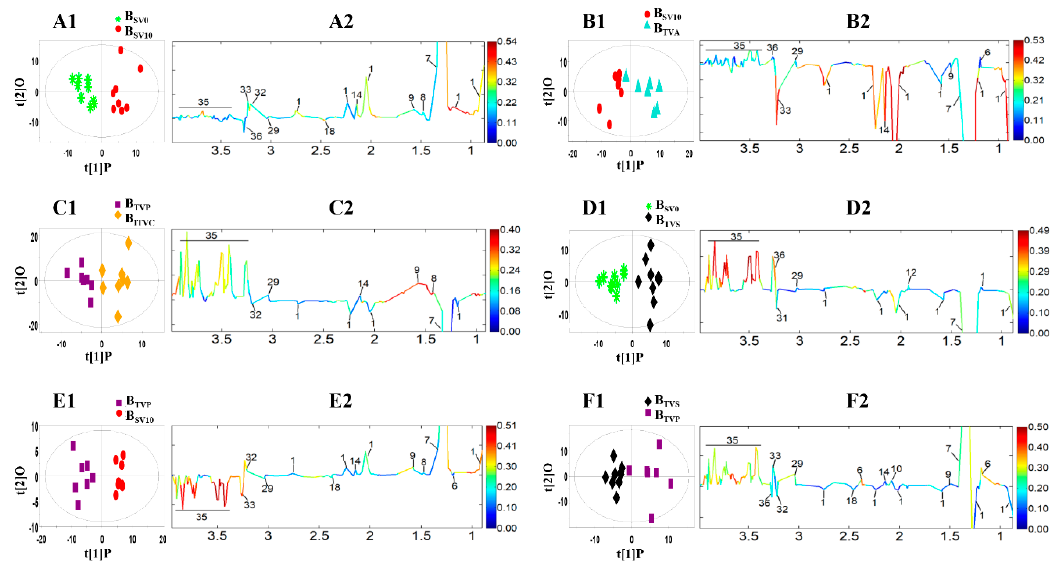
Figure 7. Score plots ( A1 – F1 ) and coefficient-coded loadings plots ( A2 – F2 ) from the results of OPLS- DA derived from 1 H-NMR spectra of the serum samples from six different comparisons A: S SV0